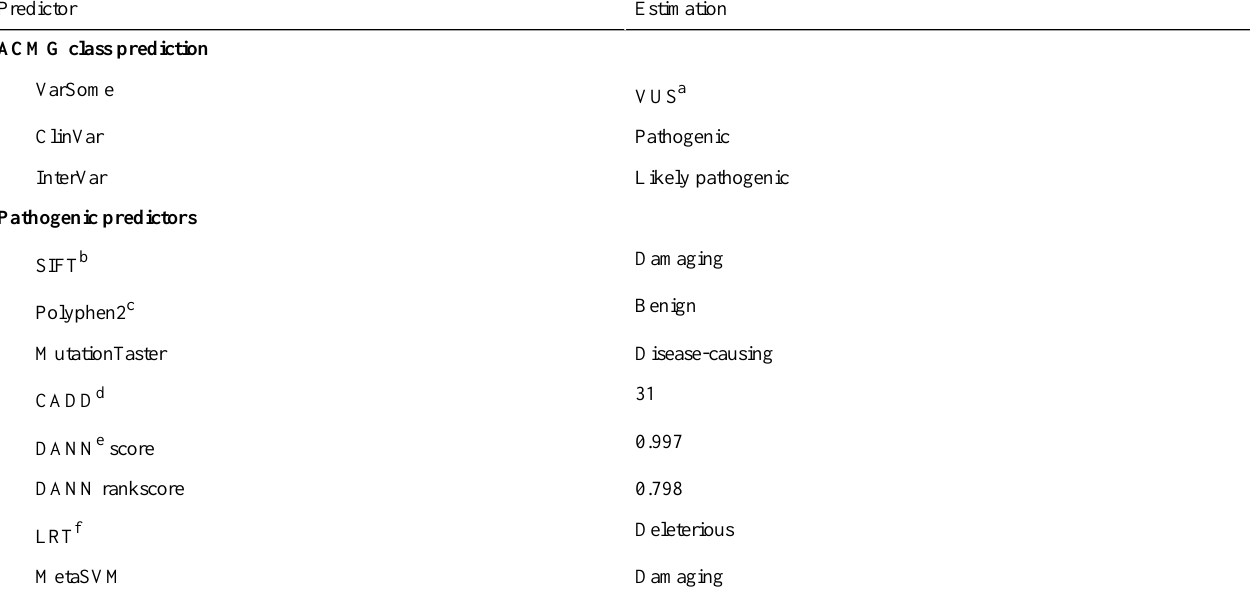
Table 2. American College of Medical Genetics and Genomics (ACMG) class predictions and pathogenic scores provided by HADA for the c.1396C>A variant found in a hereditary angioedema–affected